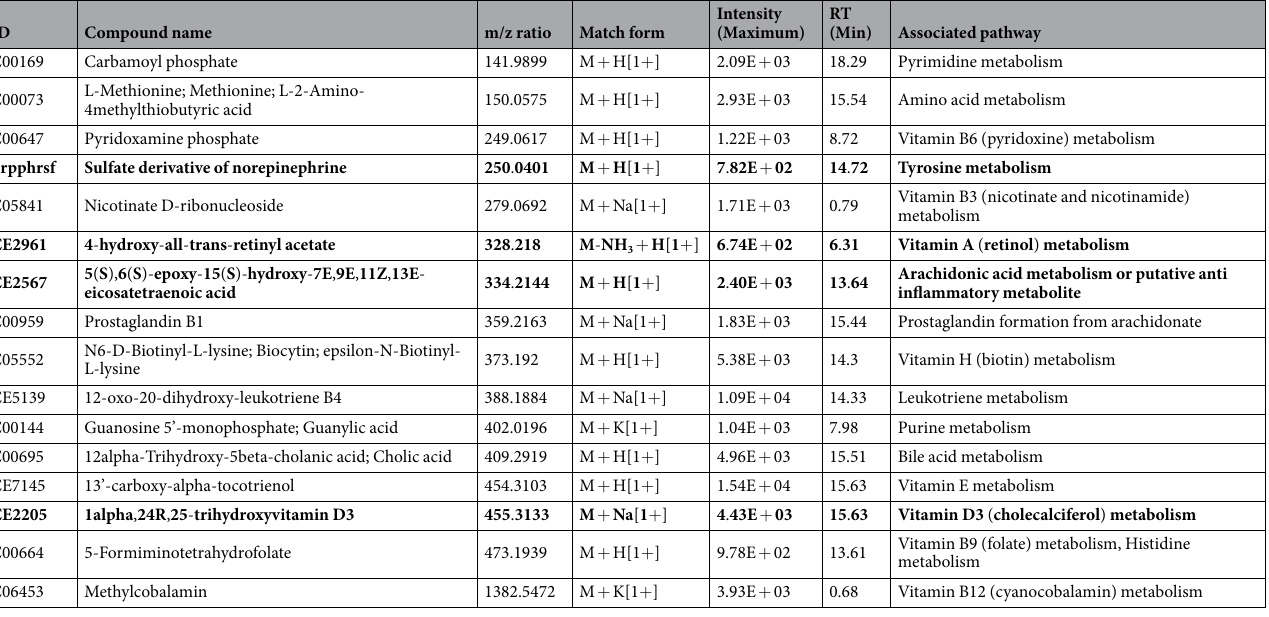
Table 1. List of components from AR, tentatively identified after LC-MS method by XCMS